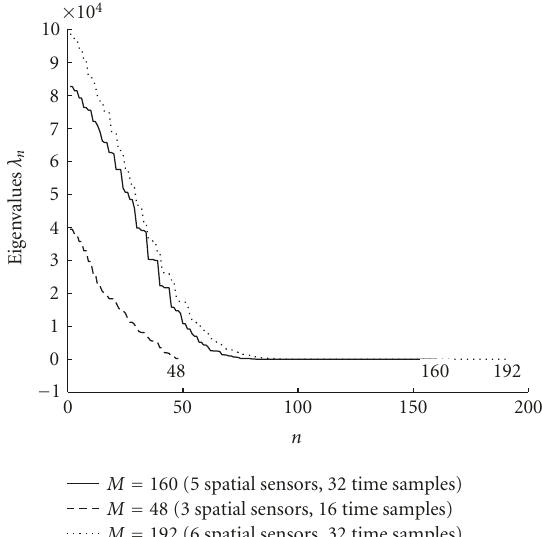
Figure 5: E ff ect of increasing sampling density in space and time on the eigenvalues λ n . All curves are for a UCA with the same ra- dius (half-wavelength spacing for 5 elements) and sampling over the same elapsed time (time for 32 samples at the Nyquist rate).